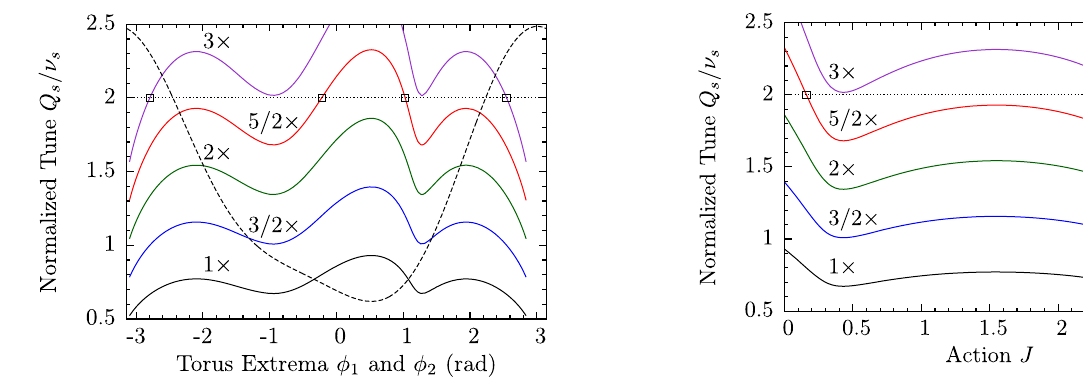
FIG. 4. Normalized synchrotron tune Q torus extrema ϕ 1 and ϕ 2 . The ν intercepts depict the location of n ∶ M parametric resonances driven by phase modulation. The dashed line overlays the asymmetric shape of the potential V ð ϕ Þ = ν rf parameters are r ¼ 1 = 2 , h ¼ 2 , and Δ ϕ